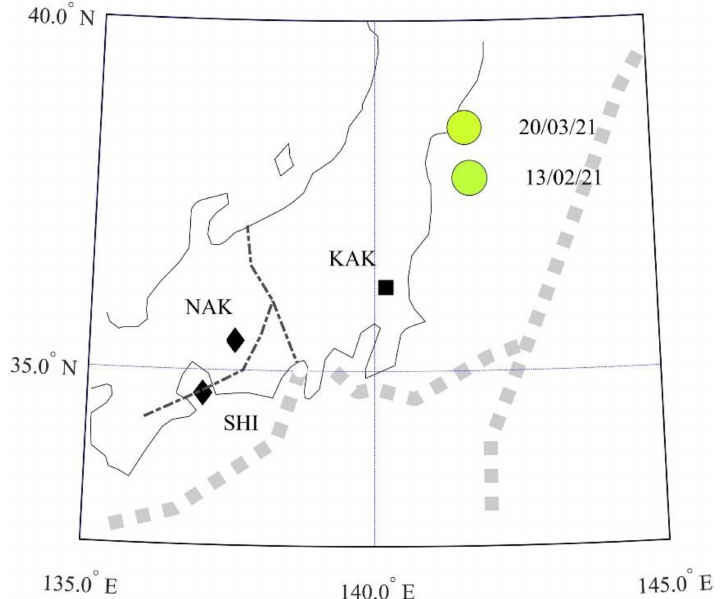
Figure 1. Locations of the ULF fluxgate magnetometer (black square) at Kakioka (KAK), ULF/ELF induction magnetometers (black rhombs) at Nakatsugawa (NAK) and Shinojima (SHI) and epicenters of the two EQs (circles) with a magnitude of M > 7 in the period of January–March 2021. The wide gray dash lines indicate the position of the trenches, and the black thin dash–dot lines in the main land display the location of the main